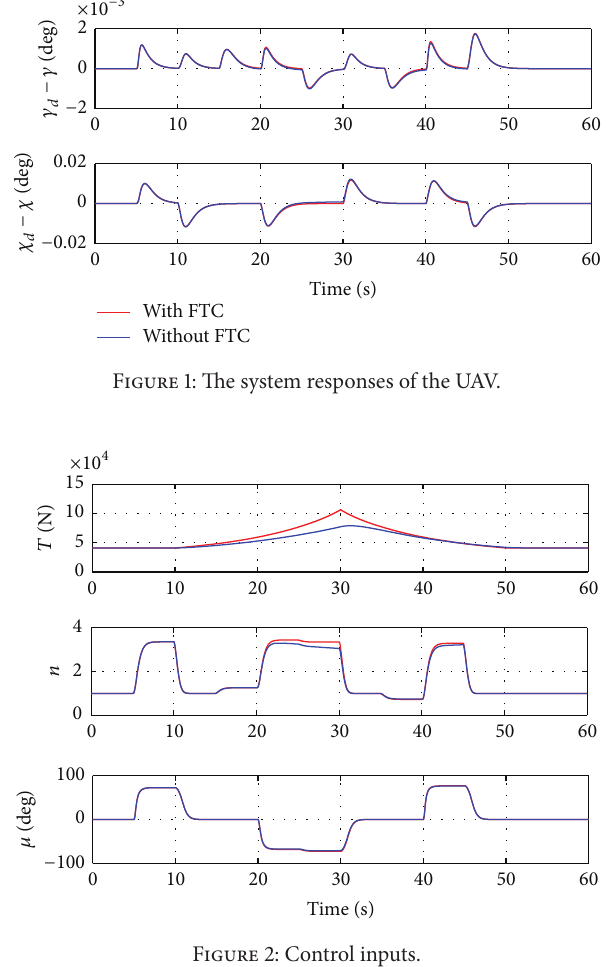
Figure 2: Control